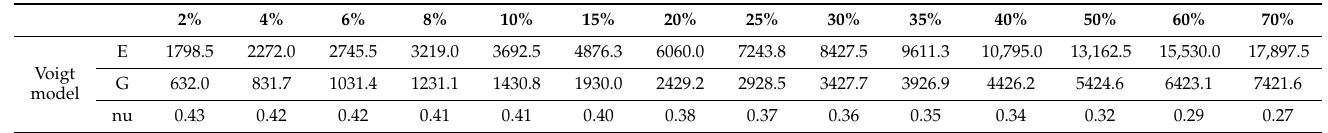
Table 2. Tubular data of